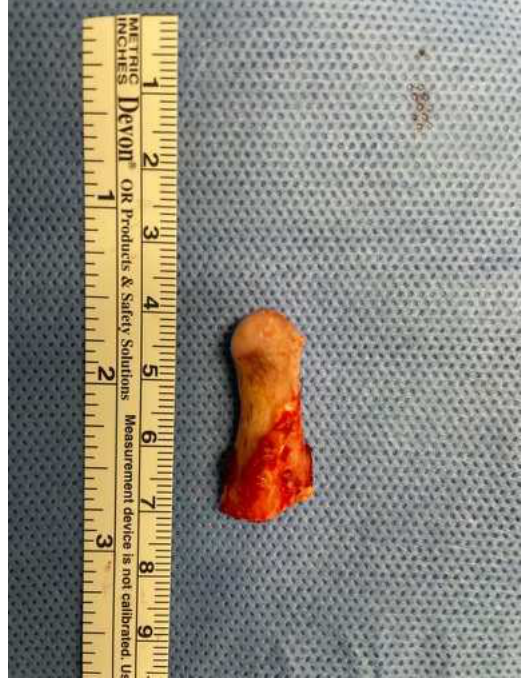
Figure 4. Right mushroom-shaped coronoid process excised.